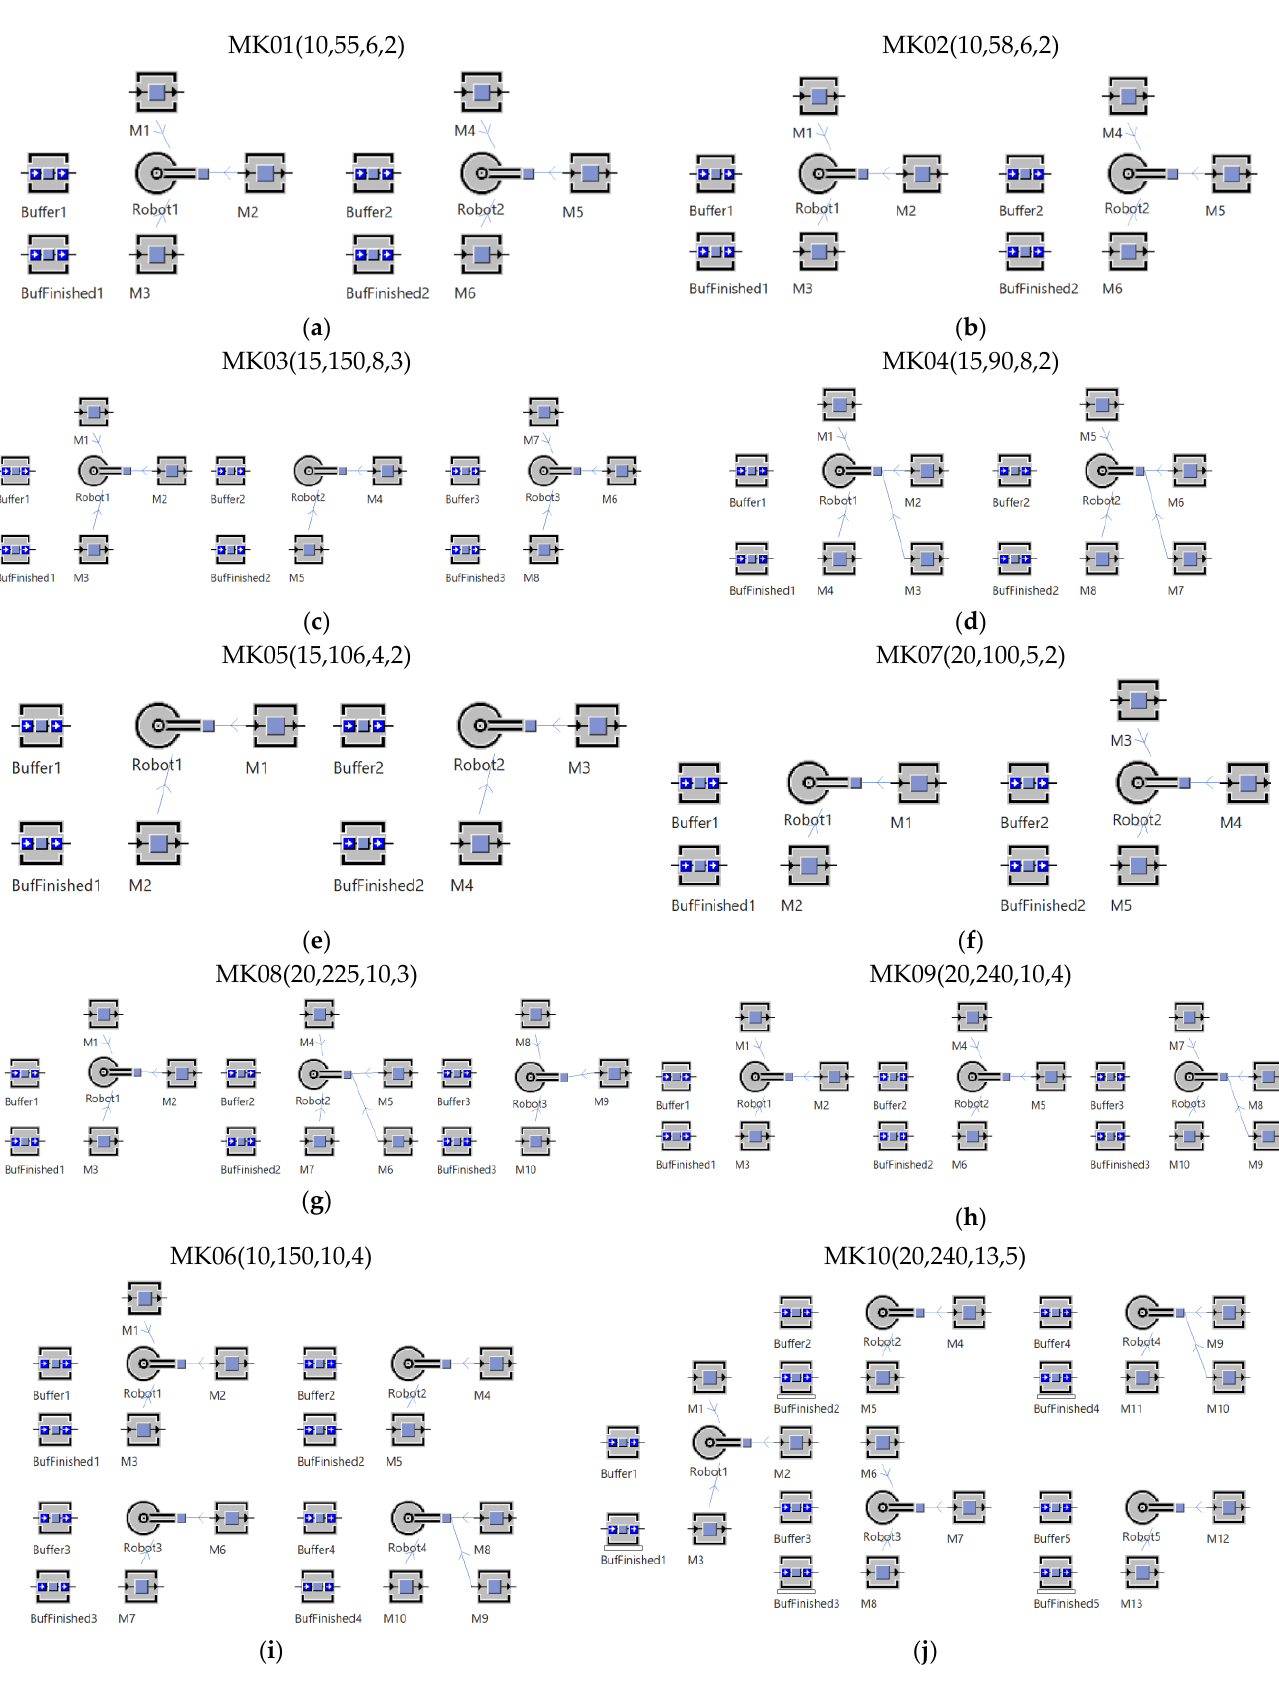
Figure 7. Example scheduling environment layout diagrams.